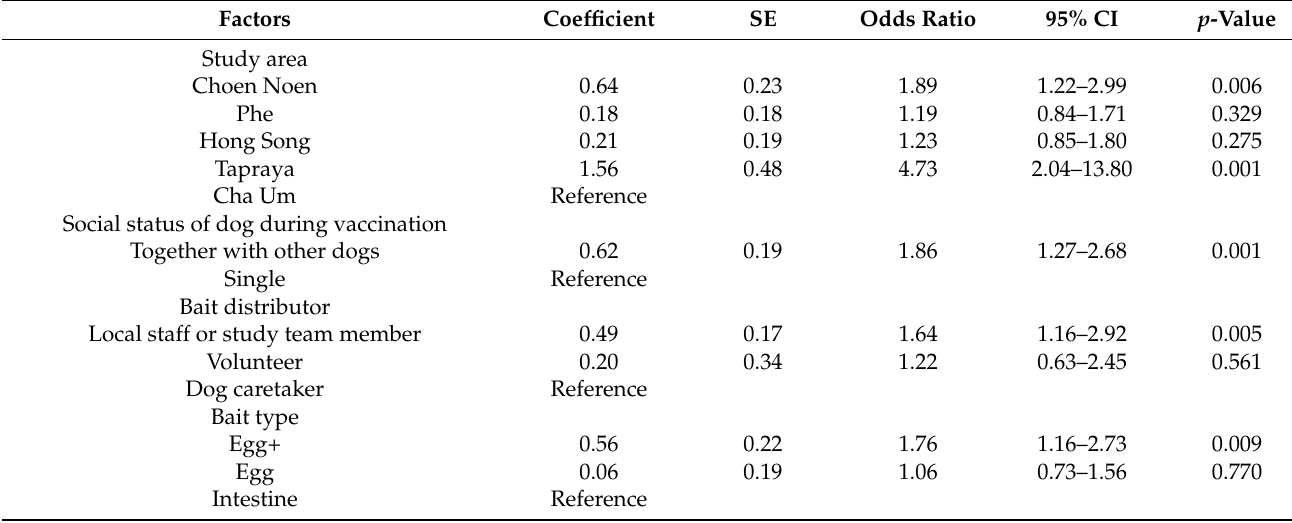
Table 3. Parameter estimates from the final multivariate model indicating factors associated with oral rabies vaccination success in free-roaming dogs in